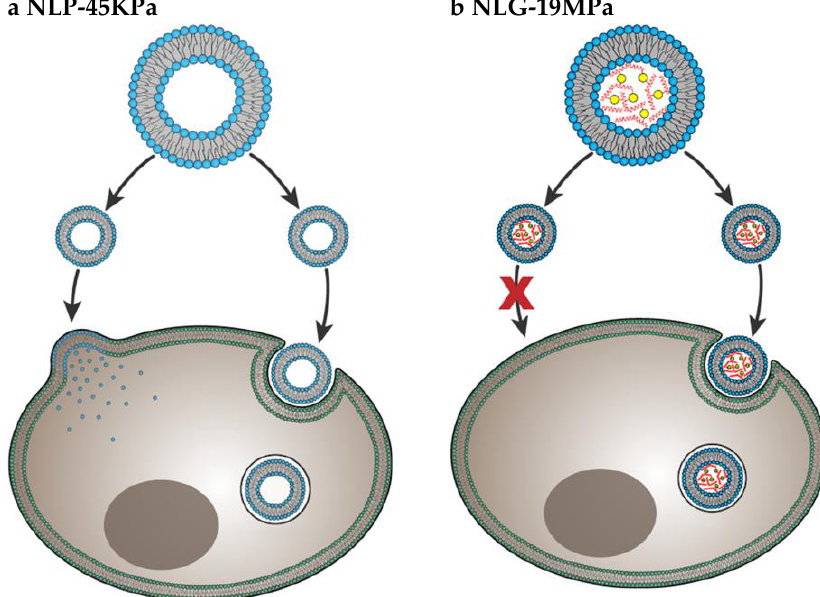
Figure 7. Cell internalization pathways of particles with different elasticity. Soft NLP-45KPa ( a ) enters the cell via two pathways: fusion and endocytosis. Hard NLG-19MPa ( b ) enters cell via only endocytosis. Adapted from Guo et al. [50].